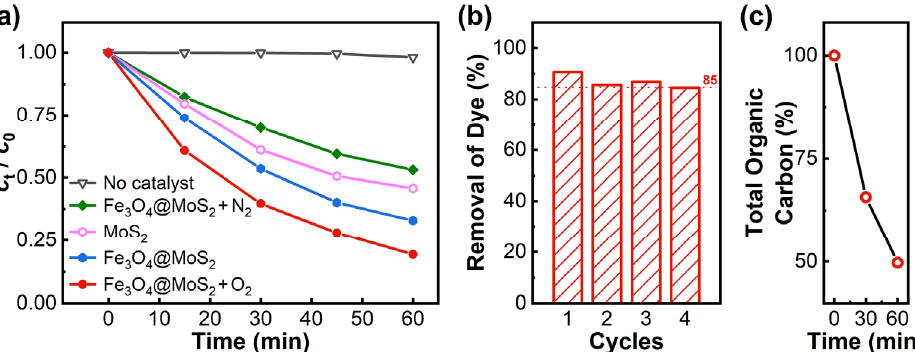
Figure 4. ( a ) Piezo ‐ catalytic degradation of rhodamine B over different catalysts under ultrasonic irradiation after an absorption equilibrium; ( b ) the cycling runs for removal (adsorption for 1 h and piezo ‐ catalytic degradation for 1 h) of rhodamine B over Fe 3 O 4 @MoS 2 ; ( c ) total organic carbon (TOC) removal during the piezo ‐ catalytic degradation of rhodamine B in the presence of Fe 3 O 4 @MoS 2 . The sample at time zero was the solution of rhodamine B that had previously reached adsorption–desorption equilibrium on the Fe 3 O 4 @MoS 2 . All experiments were carried out at 298 K using an initial concentration of 40 mg/L of rhodamine B and 1g/L of catalyst.